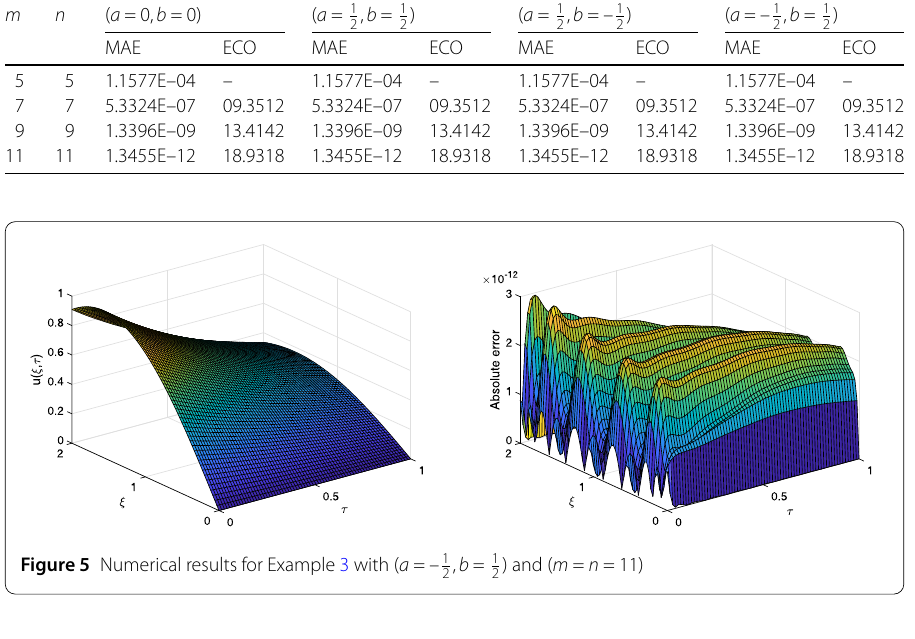
Table 1 Numerical results obtained for Example 3 with some values ( a , b )